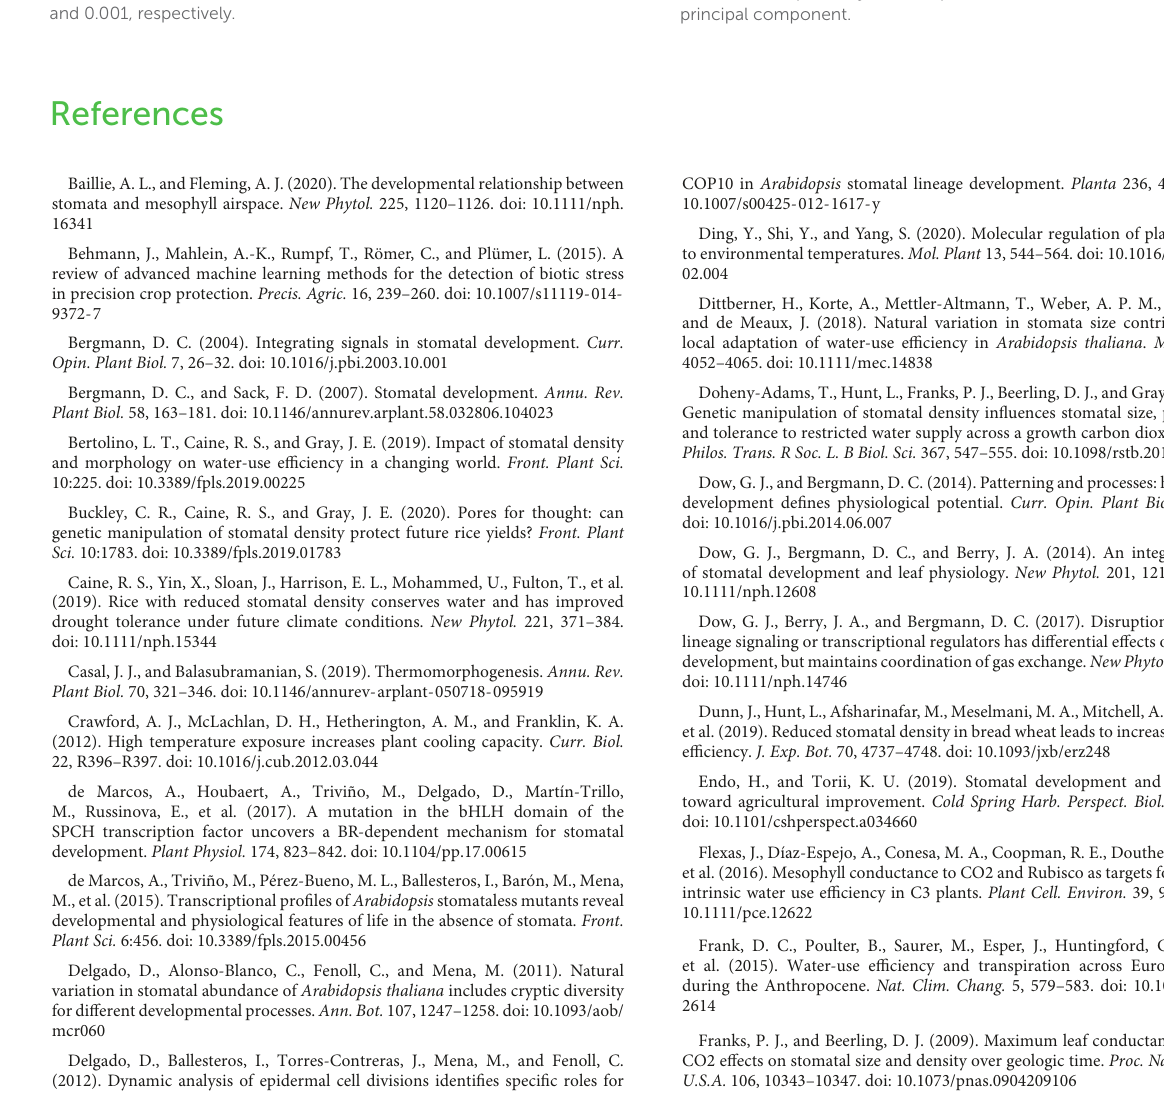
Principal components analysis (PCA) analysis of physiological and anatomical parameters, and vegetation indices. (A) Eigen values, percentage of explained variance, and cumulative explained variance for the principal components. Panels B,C show the contribution and the cos 2 value, respectively, of each parameter for each principal